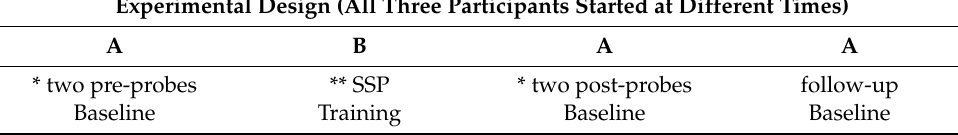
Table 1. Example of experimental design applied. Experimental Design (All Three Participants Started at Different